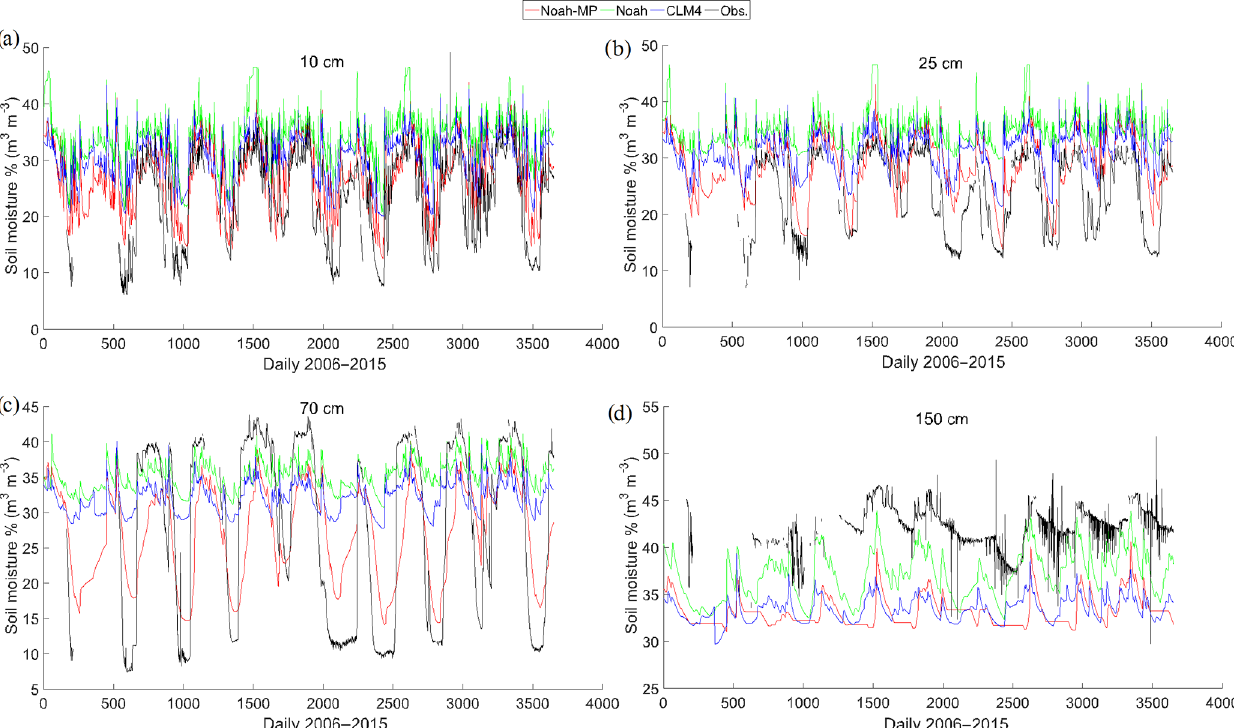
Figure 4. Soil moisture temporal variations of WRF simulations and in situ observations for four soil layers at (a) 10cm, (b) 25cm, (c) 70cm, and (d)